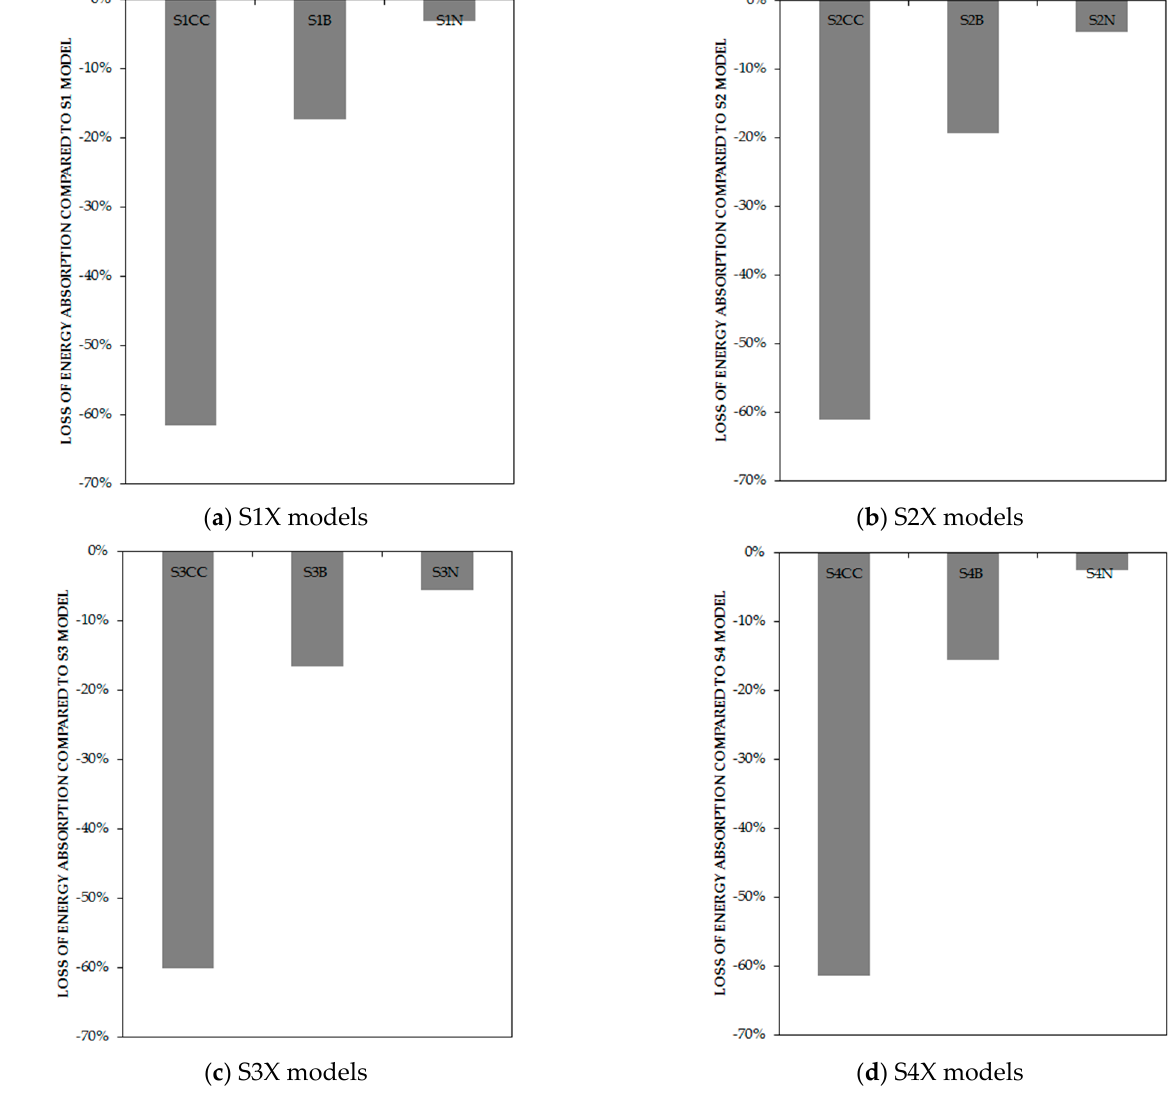
Figure 10. Loss of energy absorption of models based on the type of connections in comparison with full-connection models by percentage.